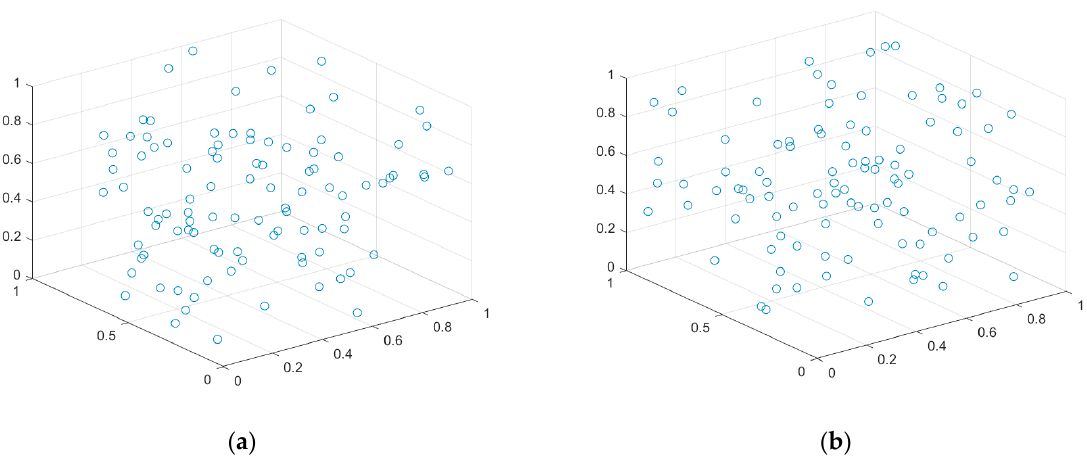
Figure 3. Network uniformity effect diagram: ( a ) Chaotic mapping; ( b ) Highly destructive polynomial mutation strategy.